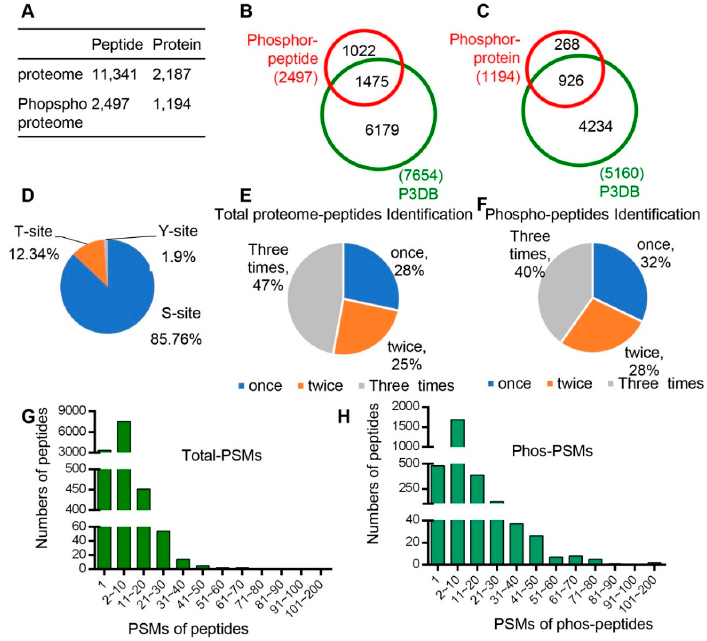
Figure 2. All peptide and phsophopeptide data were summarized and compared with database data. ( A ) Number of peptides and unique proteins that we identified from proteomes and phospho-proteomes. ( B ) Comparison of phospho-pepitides and the P3DB database (the Plant Protein Phosphorylation Database, http://www.p3db.org). ( C ) Comparison of phospho-proteins and the P3DB database. ( D ) Distribution of phosphorylated amino acids (S, T, Y) in the phospho-proteome. ( E ) Distribution of times of identification in total proteome peptides. ( F ) Distribution of times of identification in phospho-peptides. ( G ) Distribution of Peptide-Spectrum Matches (PSMs) in total proteome peptides. ( H ) Distribution of Peptide-Spectrum Matches (PSMs) in phospho-peptides.